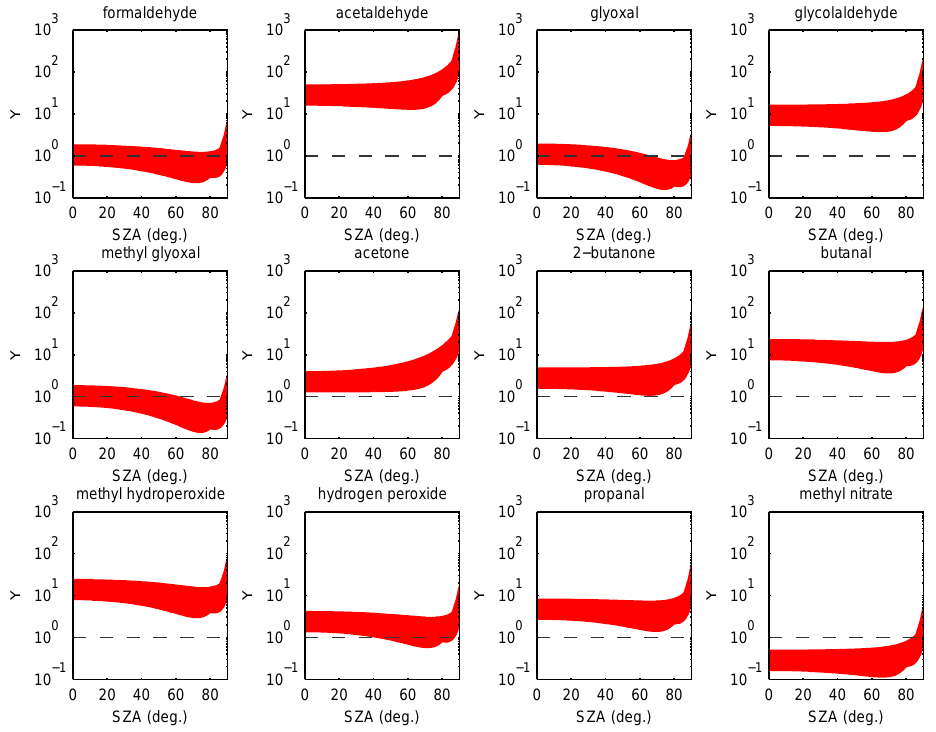
Fig. 8. The ratio of the rate of gas phase OH oxidation to the rate of gaseous photolysis, Y , as a function of solar zenith angle, SZA, for compounds where the absorption cross sections and quantum yields are published at 298K. The width of the red swath is due to the uncertainty in the empirical function relating OH concentration to the rate of O 3 photolysis. The dashed line indicates where the rate of gas phase OH oxidation is equal to the rate of gaseous photolysis, Y =